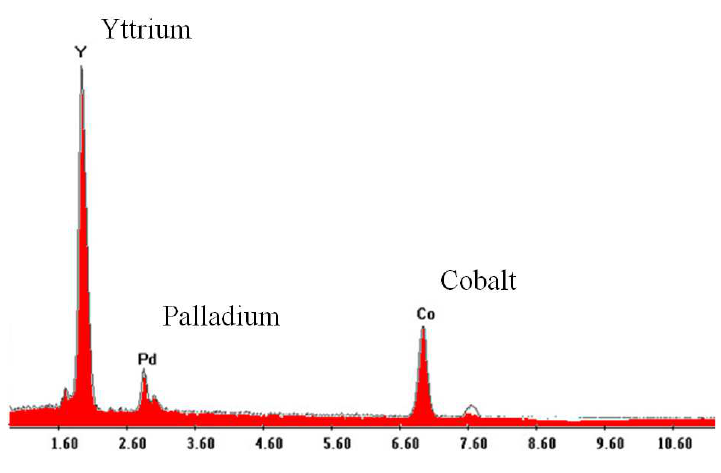
Figure 4. EDAX: micro-chemical analysis of